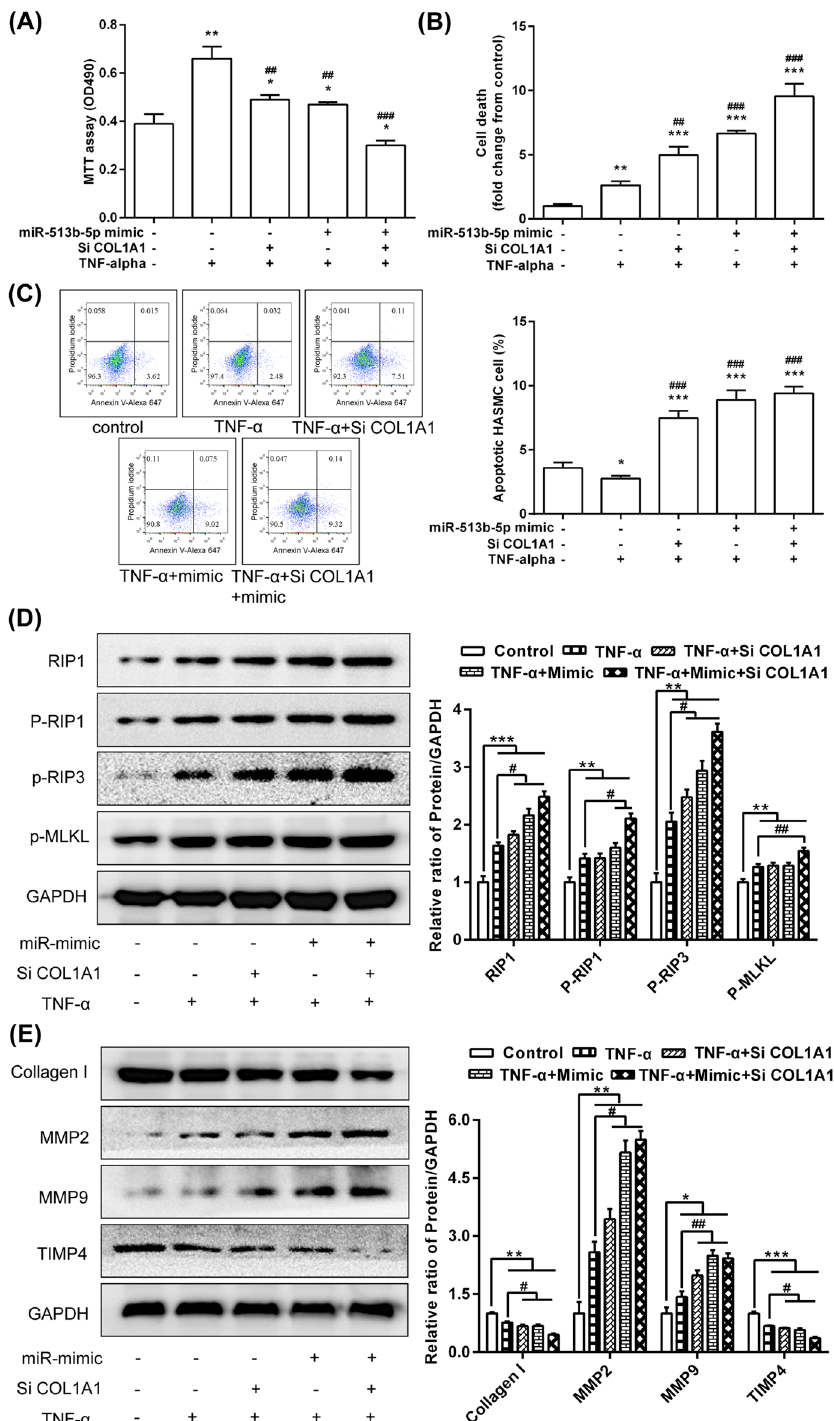
Figure 6. MiR-513b-5p/COL1A1 affected the vitality of the HASMCs during TNF-α intervention by RIP1- RIP3-MLKL and MMPs pathways. ( A ) MTT assay was used to analyse cell viability. ( B ) LDH release assay was used to detect cell death. ( C ) Flow cytometric analysis was performed to detect cell apoptosis. ( D ) Western blot was used to detect the expression of RIP1-RIP3-MLKL pathway. ( E ) The expression of related proteins in the MMP pathway. All data are expressed as means ± standard deviation, and three independent experiments were carried out. Compared with mimic NC + siRNA NC + TNF-α (−) group, * p < 0.05, ** p < 0.01, and *** p < 0.001. Compared with mimic NC + siRNA NC + TNF-α (+) group, # p < 0.05, ## p < 0.01, and ### p < 0.001. One-way ANOVA with two-sided LSD post hoc test was